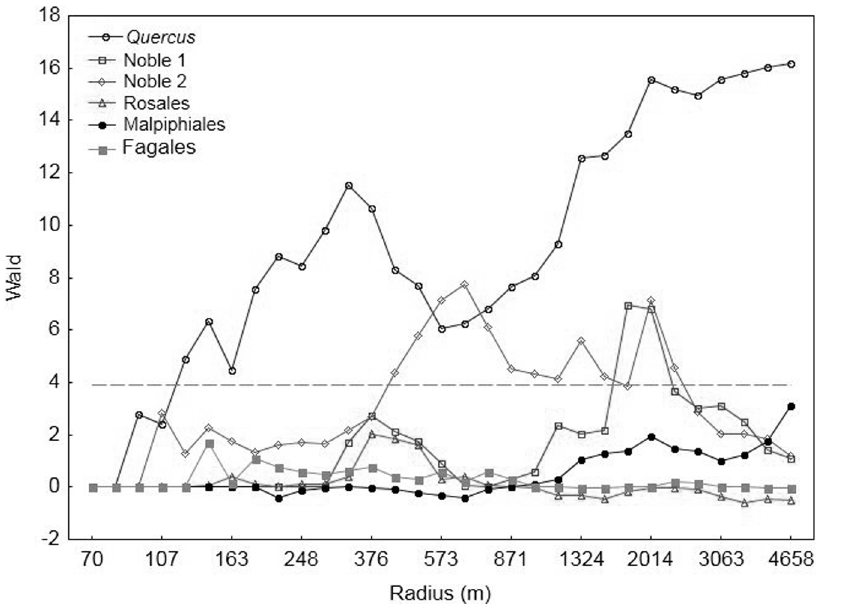
Figure 3. The relationships between occurrence of Elaterferrugineus and density of different species groups of trees. The relationships are expressed as Wald-values from 126 simple binomial GLMs. The explanatory variable tree density was measured at 31 different spatial scales and includs trees from six different groups. The grey line indicates p , 0.05, corresponding to Wald value 3.9. The Wald statistic was given negative values in cases when it indicated a negative association between probability of occurrence and tree density.